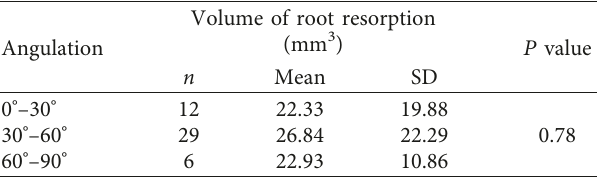
Table 6: Comparison of the MVR in terms of simultaneous effects of the canine to midline distance and angle between the canine and lateral.